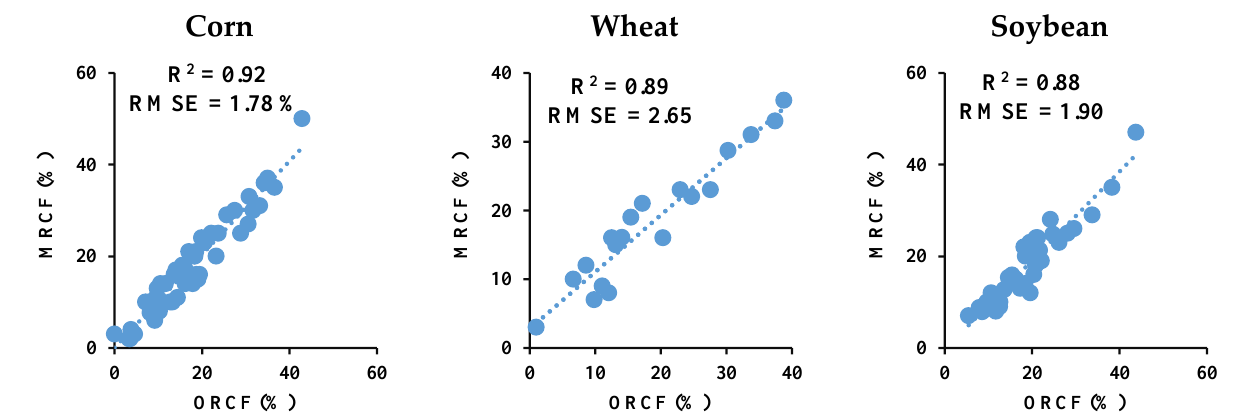
Figure 5. R 2 and RMSE between the actual and modeled RCF based on the fusion strategy at the decision level for corn, wheat and soybean crops. ORCF: observed residual cover fraction; MRCF: modeled residual cover fraction.